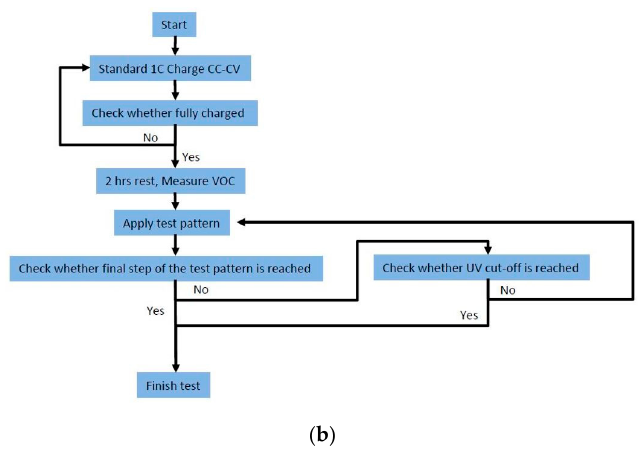
Figure 6. Test schedules: ( a ) HPPC test; and ( b ) discharging test.